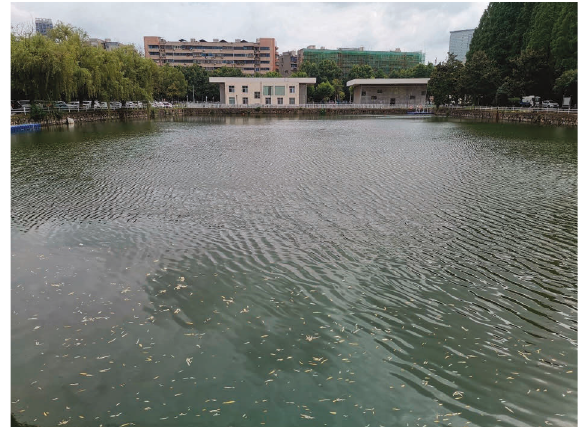
Figure 17: Outdoor pool